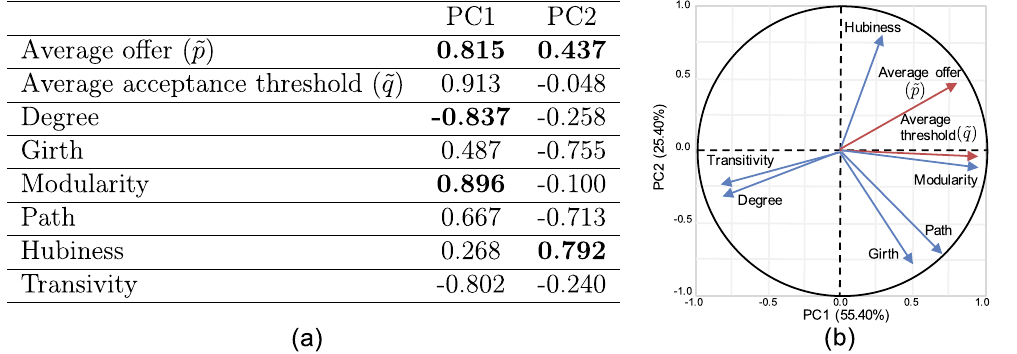
Figure 1. ( a ) Correlations between the initial variables and the independent principal components. Significant correlations are in bold. Average offer is highly correlated with PC1 and moderately correlated with PC2. Modularity is highly correlated with PC1, while Degree is negatively correlated with PC1. Hubiness is highly correlated with PC2 ( b ) Principal Component Analysis results summary. The biplot shows the correlation between initial variables based on the first two principal components. The angles between the variables represent the level correlation. Strategies are initialized from uniform distribution U (0, 1) and normalized accumulated payoff per the agent’s degree is used as the game score.